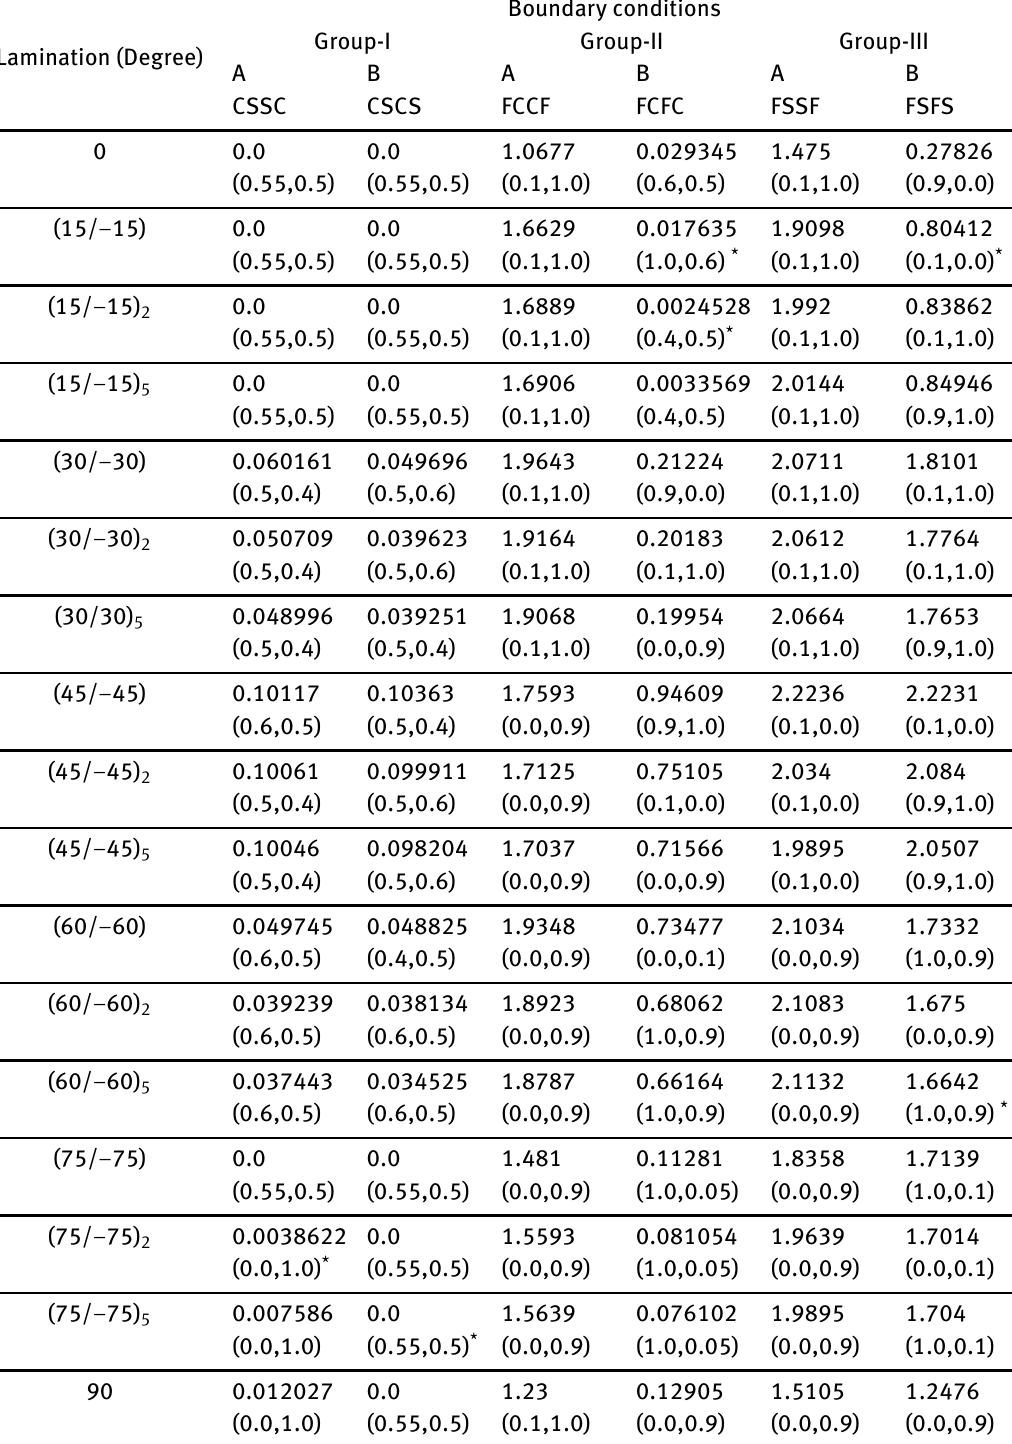
Table 8: Values of maximum non-dimensional anticlockwise in-plane shear (+ N xy ) for different antisymmetric angle ply lamination and boundary conditions of stiffened composite hypar shell with